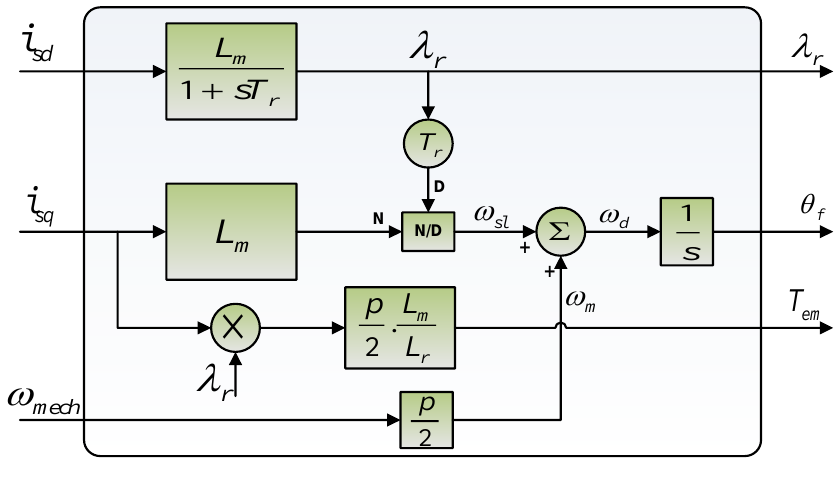
Figure 4. The estimated model for θ f calculation.